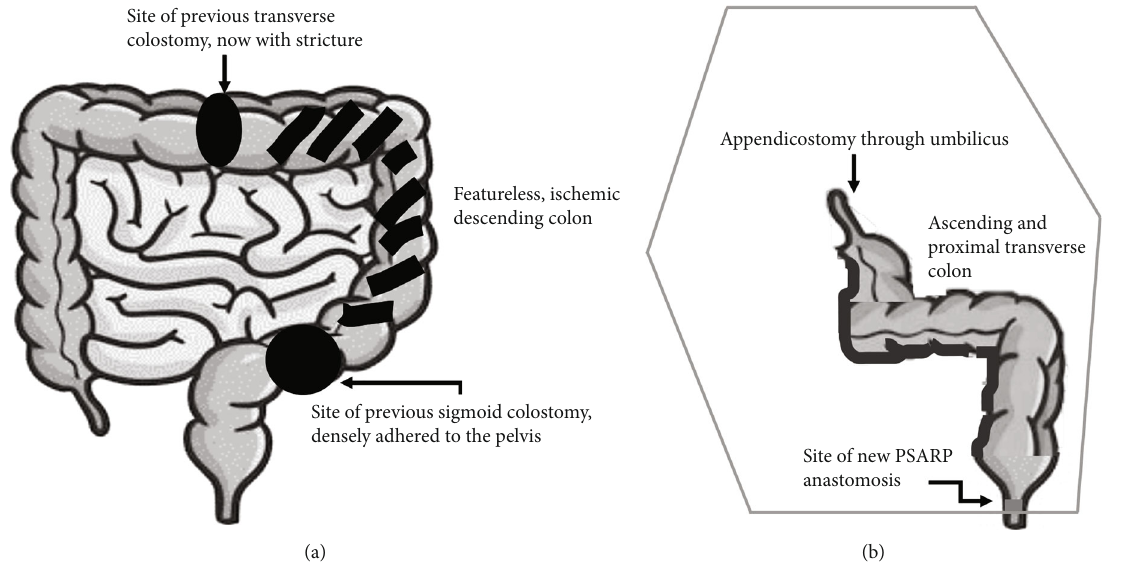
Figure 5: (a) Anatomy of the patient ’ s colon prior to redo-PSARP, indicating the sites of her previous colostomies and the ischemic descending colon. (b) Final anatomic con fi guration after colon resection and redo-PSARP. Her neoappendicostomy is anastomosed to her umbilicus, while the ascending and proximal transverse colon were derotated to allow for a new coloanal